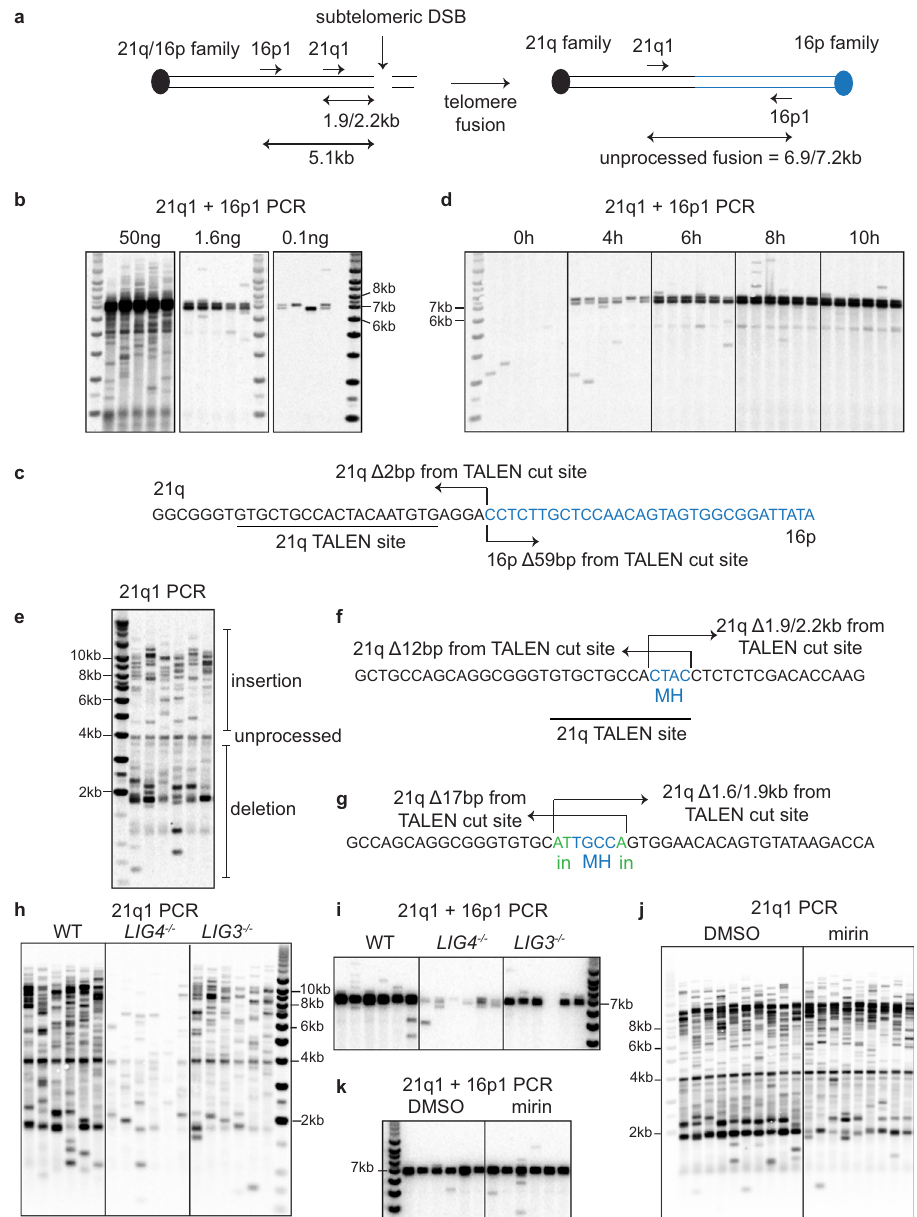
Fig. 1 DNA resection contributes to deletion formation at telomere fusion. a Diagram of 21q/16p TALEN induced telomere fusion PCR assay, with position of primers, the distance of primers to the cleavage site and the expected size of fusion product indicated. b 21q1 + 16p1 telomere fusion analysis (a representative image from two independent experiments) using the indicated amount of DNA isolated from RPE1-hTERT (RPE1) cells 48 h after TALEN nucleofection. Telomere fusion products were detected with a 16p telomere adjacent probe. c Fusion between 21q and 16p family telomeres characterized by Sanger sequencing of re-ampli fi ed and puri fi ed PCR products, with the number of nucleotides deleted indicated by Δ bp. d 21q1 + 16p1 telomere fusion assay using DNA (50 ng) isolated from RPE1 cells at the indicated time after nucleofection. e 21q1 telomere fusion assay (a representative image from four independent experiments) using DNA (50 ng) isolated from RPE1 cells 48 h after nucleofection. Telomere fusion products were detected with a 21q telomere adjacent probe. f , g Examples of fusion between 21q family telomeres characterized by Sanger sequencing of re-ampli fi ed and puri fi ed PCR products, with the number of nucleotides deleted ( Δ bp), microhomology (MH) and insertions (in) indicated. h , i 21q1 or 21q1 + 16p1 telomere fusion assay using DNA (50 ng in h, 1.6 ng in i ) isolated from HCT116 WT or LIG3/LIG4 KO cells 48 h after nucleofection, with quanti fi cation of fusion bands from three independent experiments shown in Supplementary Fig. 1d – e. j , k 21q1 or 21q1 + 16p1 telomere fusion assay using DNA (50 ng in j , 1.6 ng in k ) isolated from RPE1 cells treated with DMSO or 50 µ M mirin 48 h after nucleofection, with quanti fi cation of fusion bands from two/three independent experiments shown in Supplementary Fig. 1f –